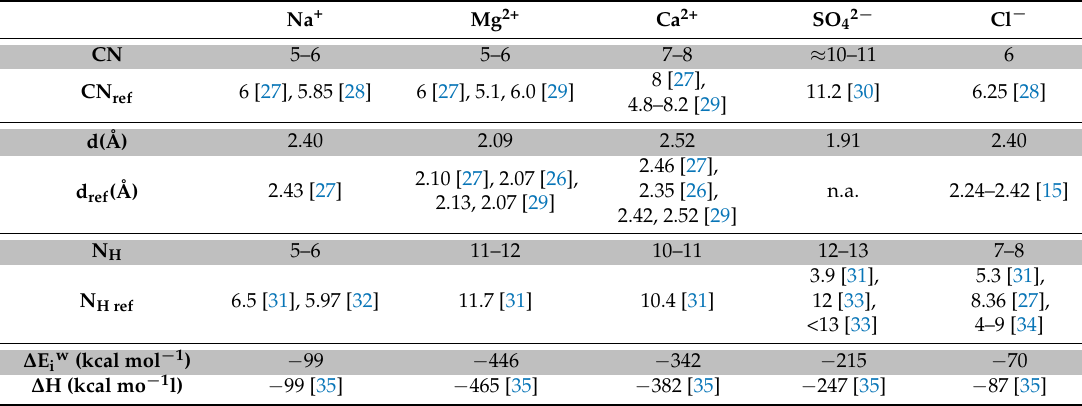
Table 1. Comparison between computed (grey rows) and experimental (from literature, white rows) solvation properties: coordination number (CN), ion-water minimum distance (d), hydration number (N H ), hydration energy and hydration enthalpy ( ∆